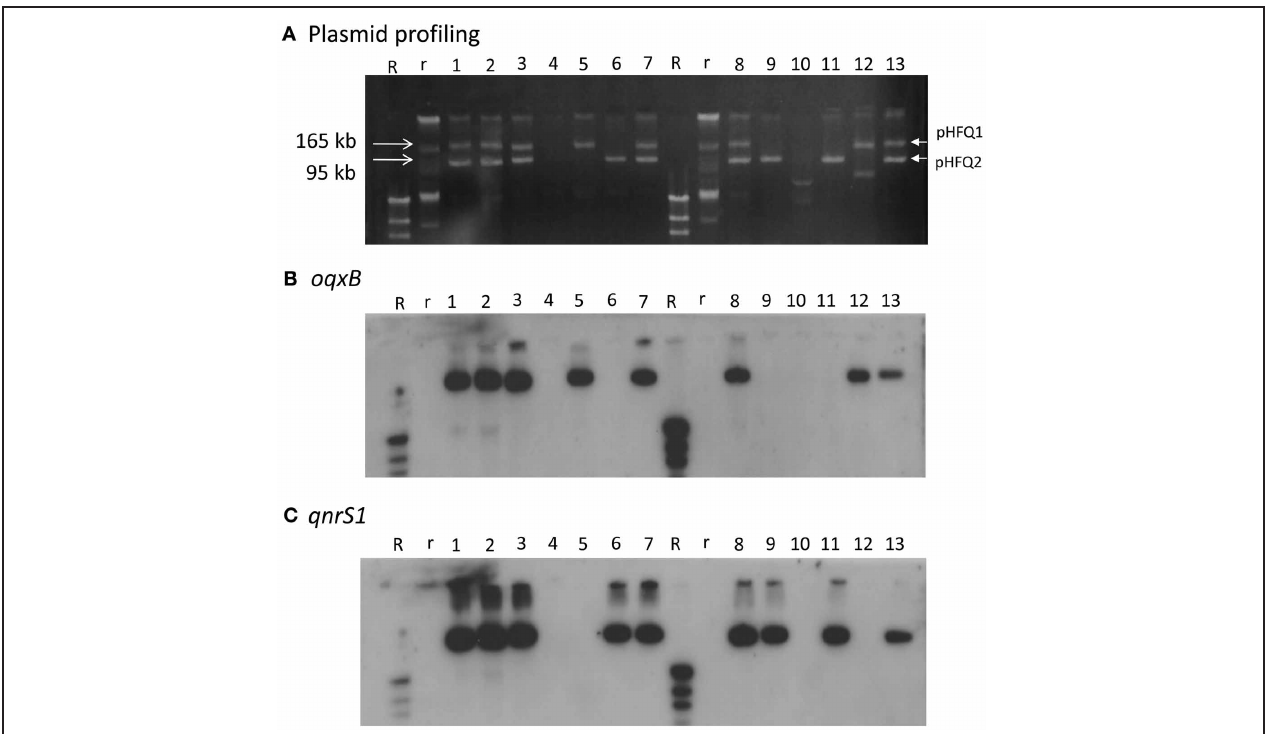
2, HUE1A2; lane 3, HUE1A; lane 4, HUE1A-Curoqxqnr; lane 5, HUE1A-Reoqx; lane 6, HUE1A-Reqnr; lane 7, HUE1A-Reoqxqnr; lane 8, HUE1; lane 9, HUE1B-Curoqx; lane 10, HUE1B-Curoqxqnr; lane 11, HUE1B-Reqnr; lane 12, HUE1B-Reoqx; lane 13, HUE1B-Reoqxqnr;